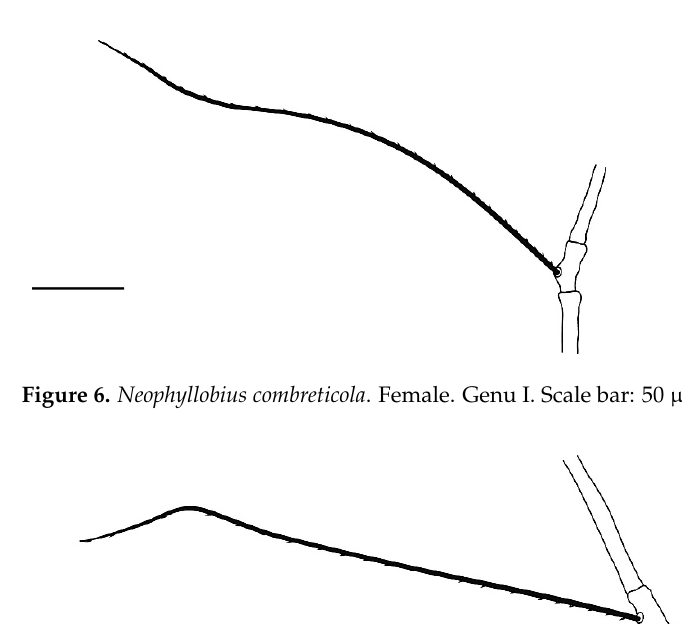
Figure 7. Neophyllobius combreticola . Female. Genu II. Scale bar: 50 μ m.